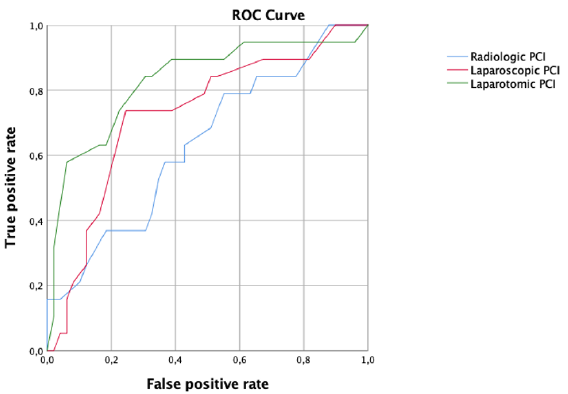
Figure 8. Receiver operating characteristic (ROC) curve comparing radiologic (blue line), laparoscopic (red line) and laparotomic (green line) peritoneal cancer index (PCI) in women who underwent interval debulking surgery.